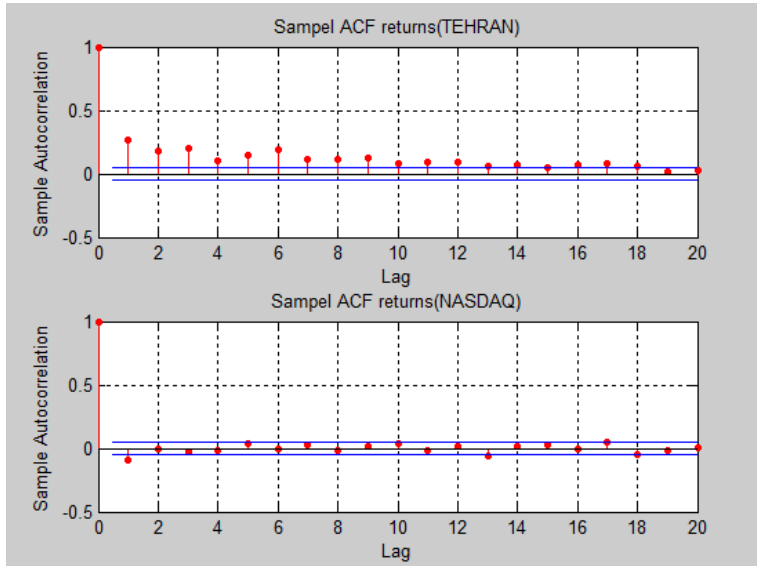
Fig. 3. Sample ACF of the